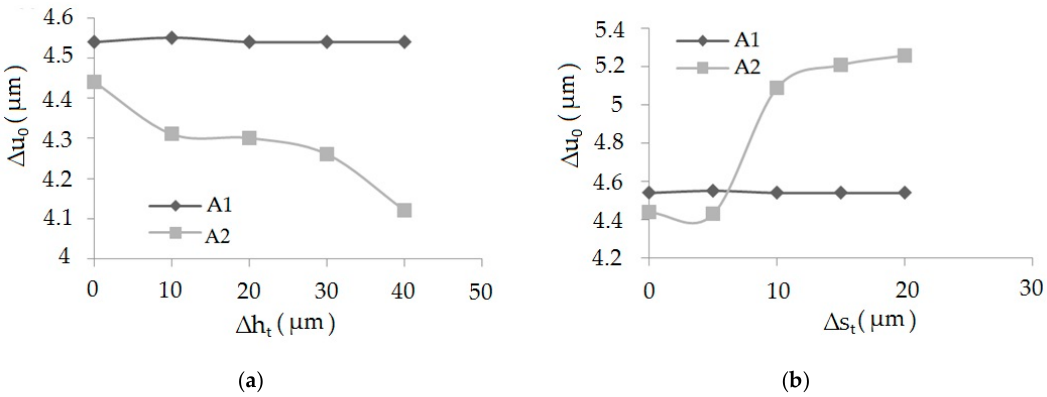
Figure 9. The graphs of dependencies of elastic recovery ∆ u 1 and ∆ u 2 accordingly in the asperities A1 and A2 , from height deviation, ∆ h t ( a ), and dependencies of elastic recovery ∆ u 1 and ∆ u 2 accordingly in the asperity A1 and A2 from distance deviation, ∆ s t ( b ).